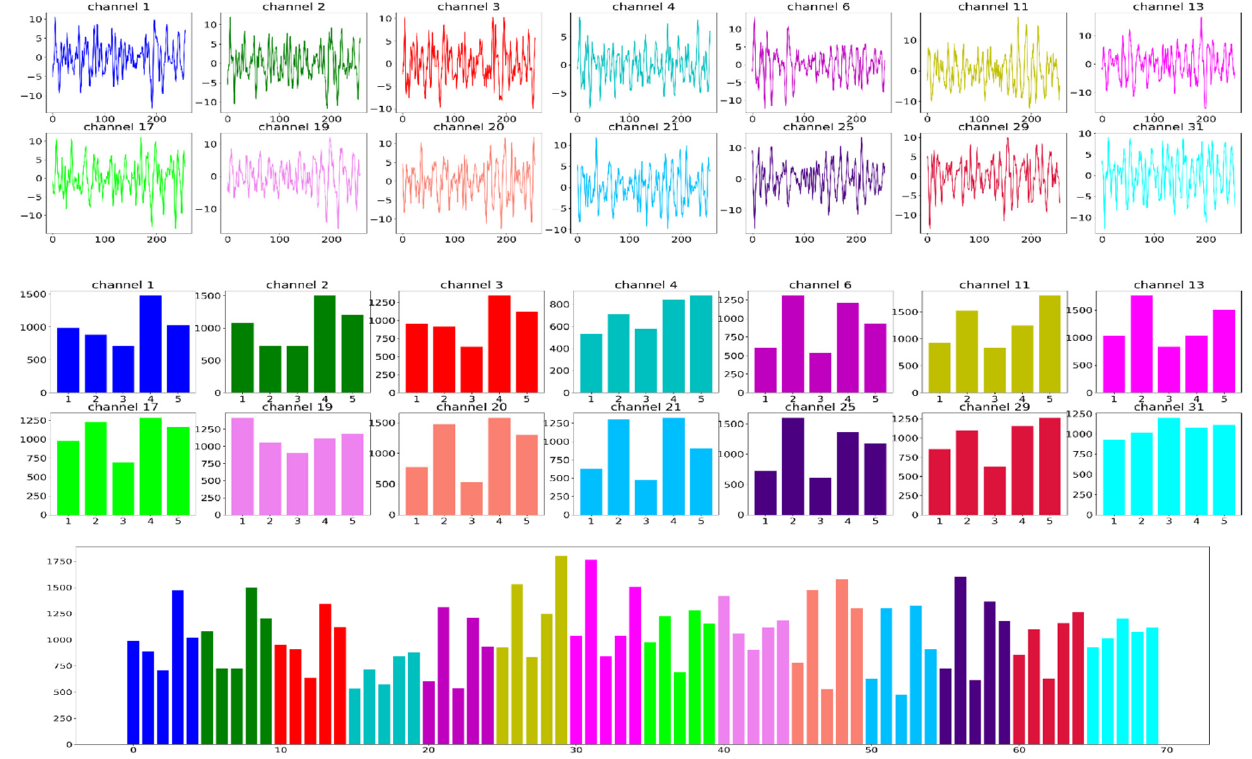
Figure 5. Steps of FFT on selected 14 EEG channels and 5 sub-bands of DEAP dataset. A total of 14 channels [channel no: 1, 2, 3, 4, 6, 11, 13, 17, 19, 20, 21, 25, 29, and 31] are selected and 2 s of EEG data is segmented which consists of 256 floating points. This goes into the FFT function and the FFT is applied on every channel which is shown in the 2nd graph. In this final step, all the channel-wise FFT output is merged together to form a single data point of the data. A single data point has 70 values (14 channels × 5 FFT bands).